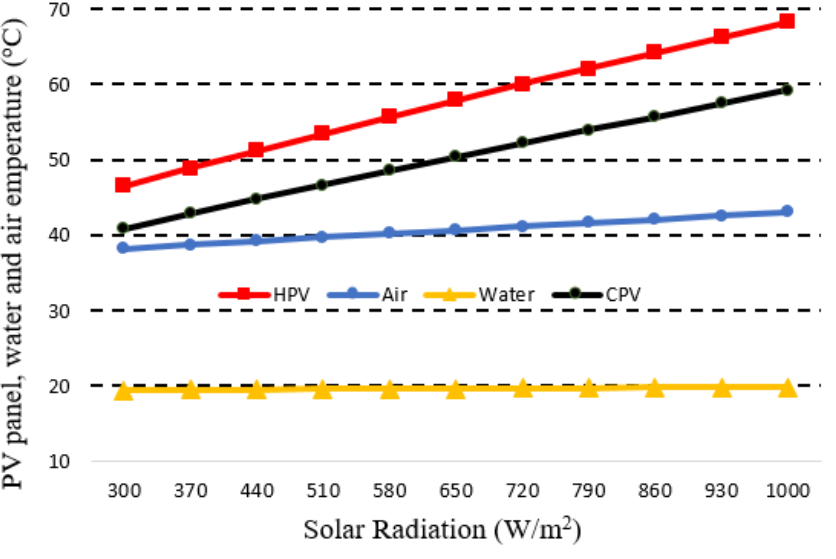
◦ C and T ◦ li = 20 ai = 40